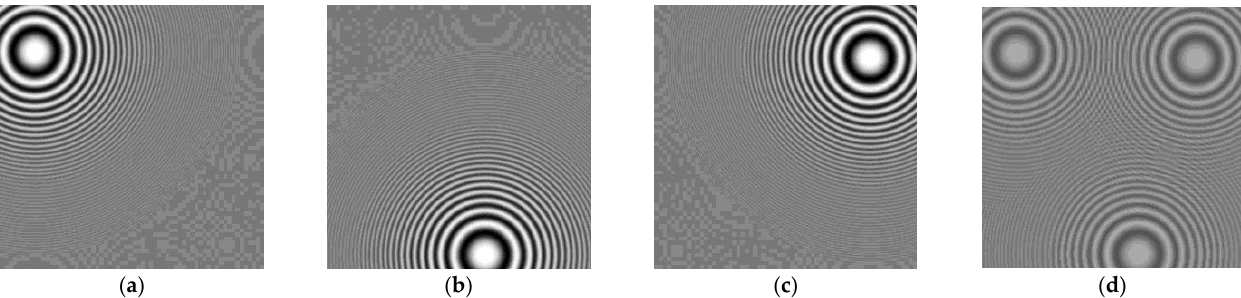
Figure 10. ( a – c ) Three determined single circular patterns separated by using the proposed method; ( d ) the mixed fringe pattern of three ( a – c ) separated signals.